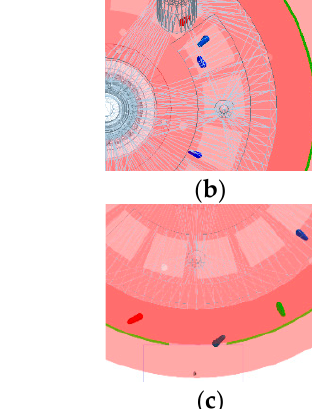
Figure 15. Seeding performance analysis